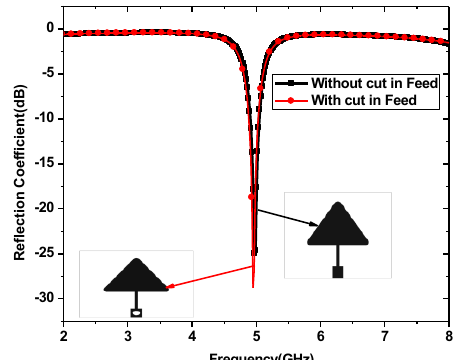
Without cut in Feed With cut in Feed